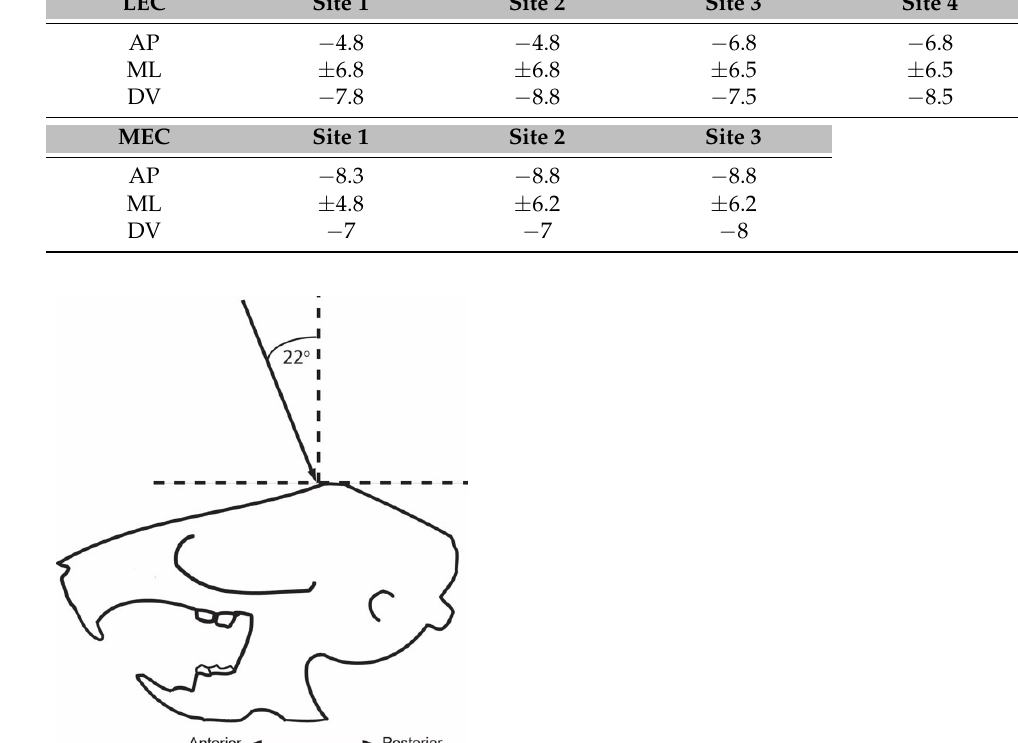
Table 1. Stereotaxic coordinates for LEC and MEC lesions taken from bregma (in mm).